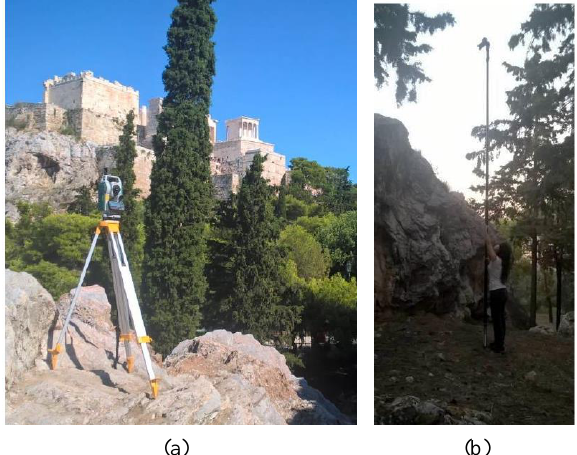
Figure 2: Data acquisition. (a) The total station used to measure the coordinates of the targets, (b) The camera attached to the patented mast.